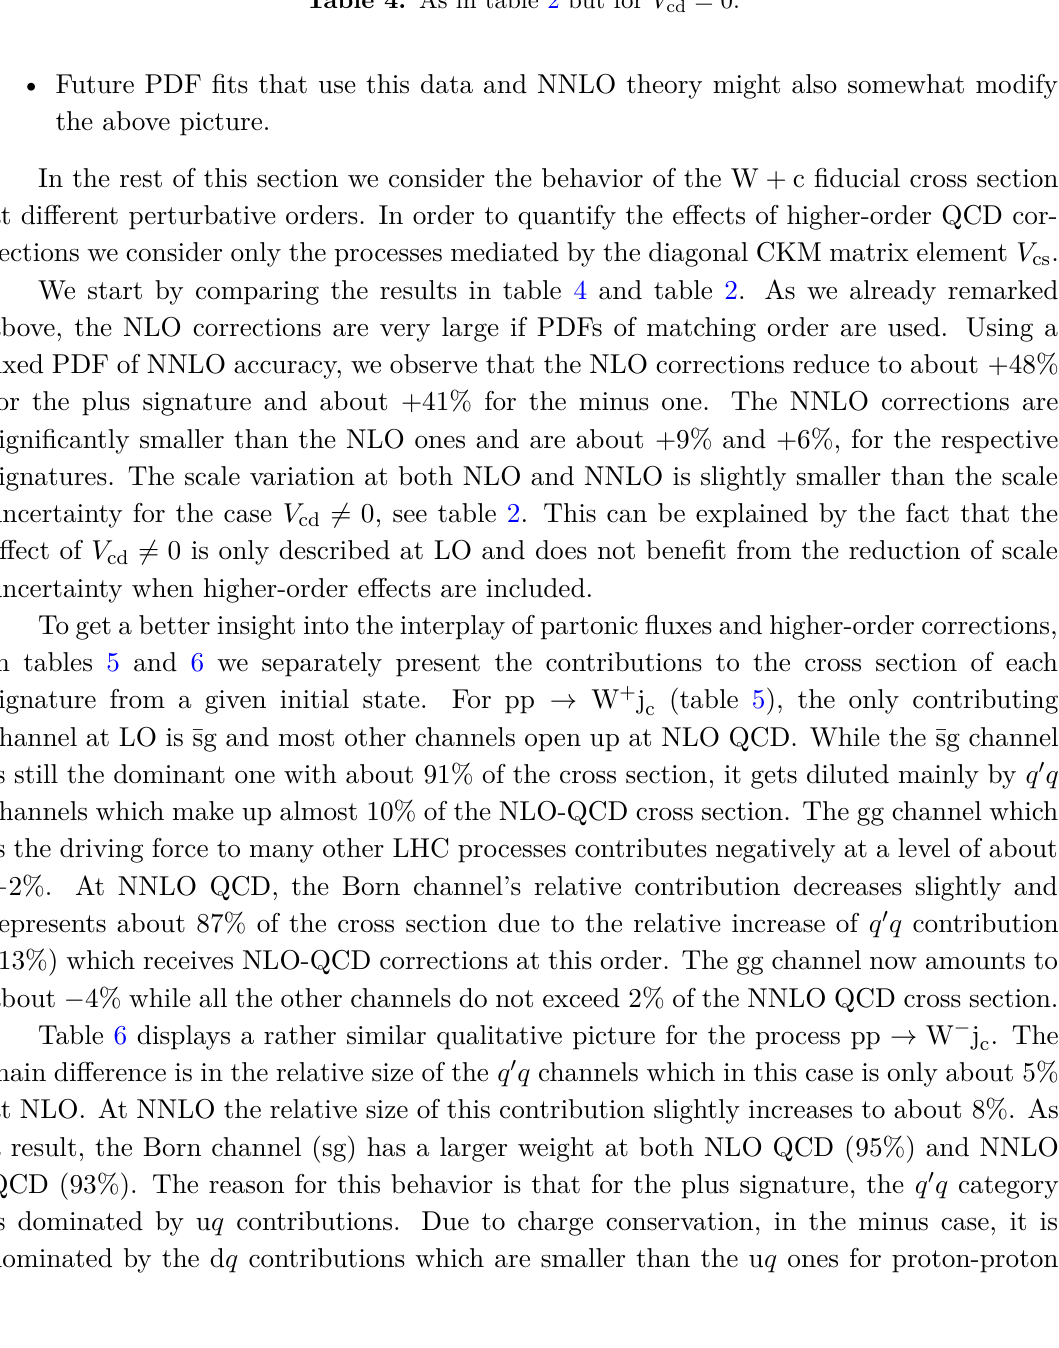
Table 4. As in table 2 but for V cd = 0